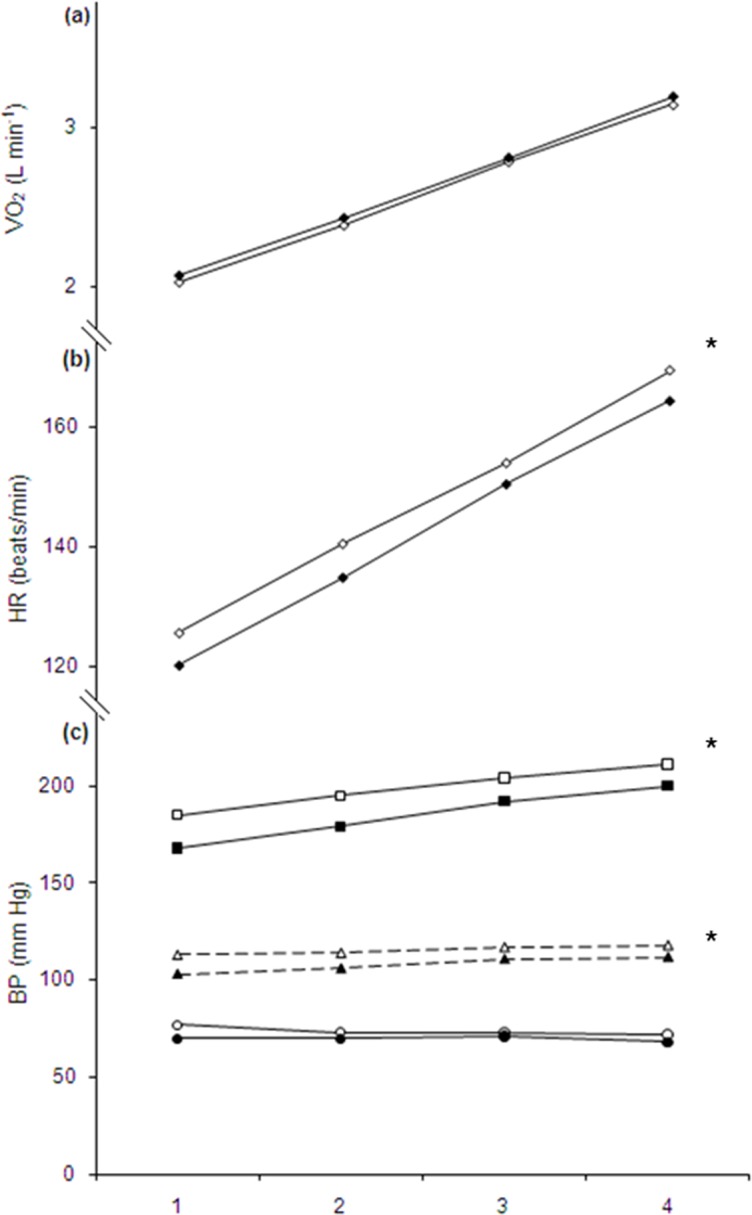
Mean changes in (a) oxygen uptake (VO2), (b) heart rate (HR), and (c) blood pressure (BP) during submaximal work rate 1: 50%, 2: 60%, 3: 70% and 4: 80% of individual VO2max. Open symbols indicate pre- and solid symbols indicate post-SCP (snuff cessation period). There were significant differences in mean value of HR and BP between pre- to post-SCP conditions (ANOVA). VO2 was unchanged.